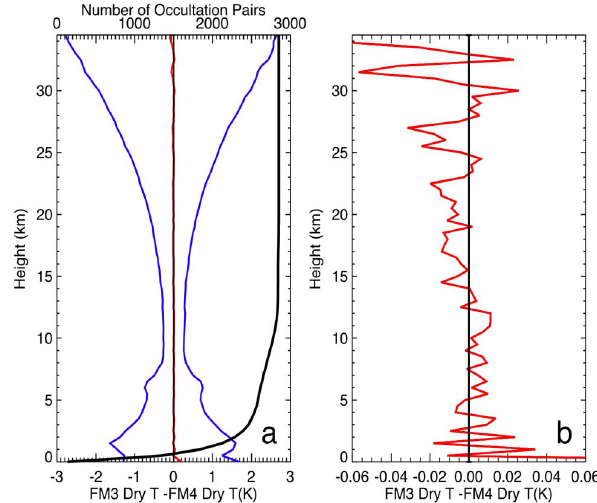
Fig. 9. Statistics showing “dry temperature” differences between two nearby COSMIC Satellites (FM-3 and FM-4) within 10km of each other: (a) mean difference (red line near center), standard de- viation of the differences (blue lines) and number of pairs of data (black line); (b) enlarged view of mean differences. The statistics indicate no significant bias difference between the two instruments on different platforms and a precision of 0.02–0.05K at all levels (Ho et al.,